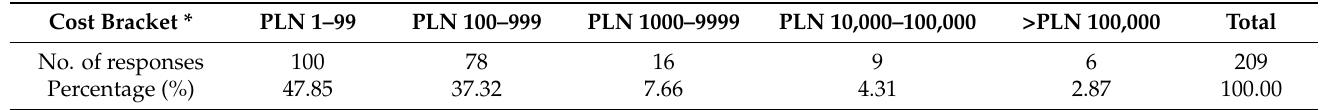
Table 5. Responses to the fifth question: how much would you be inclined to pay for a digital work of art?